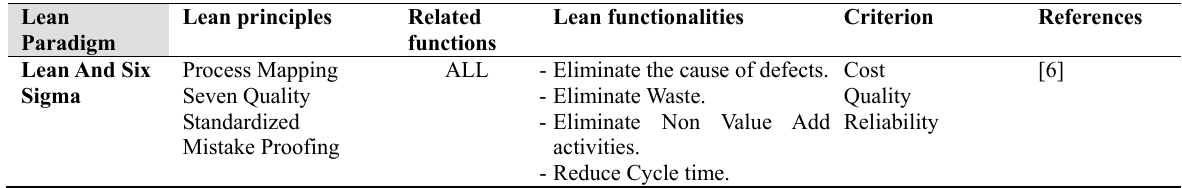
Lean functionalities Criterion functions